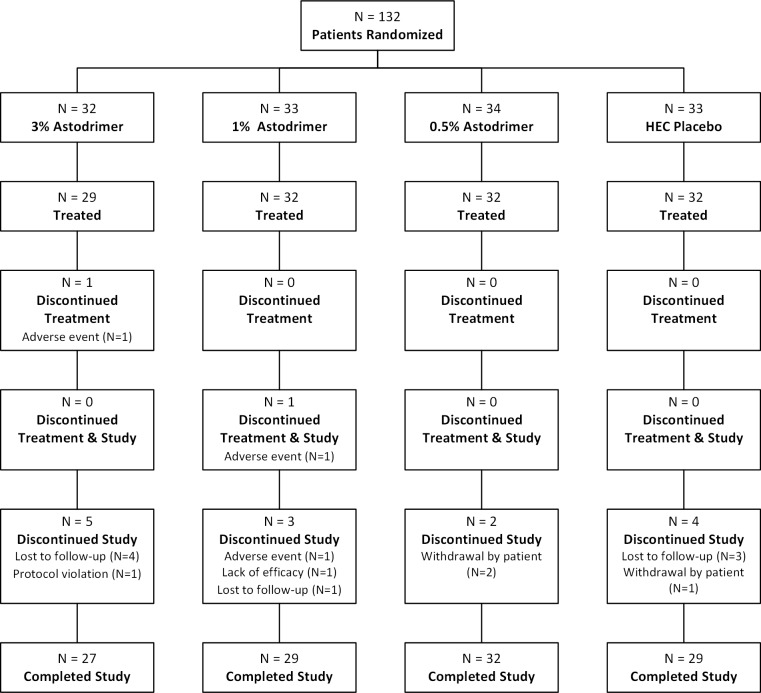
Consort diagram.Patient enrollment by treatment group.